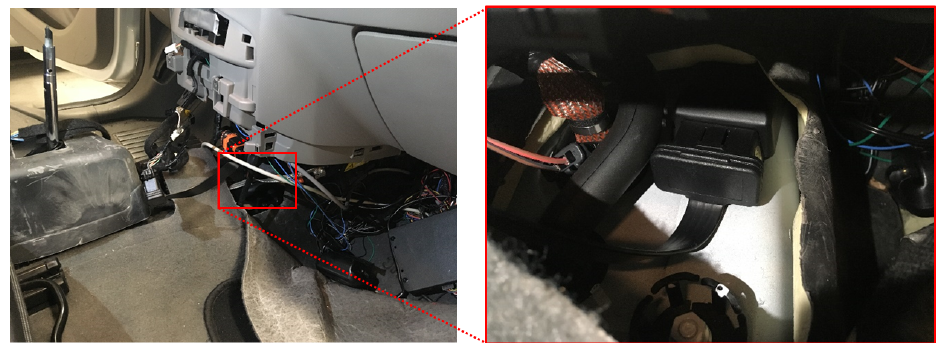
Figure 2. Picture of the passenger side of the Renault Zoe with the access panel to the middle console removed and the location of the AutoPi telematics unit inside the middle console.